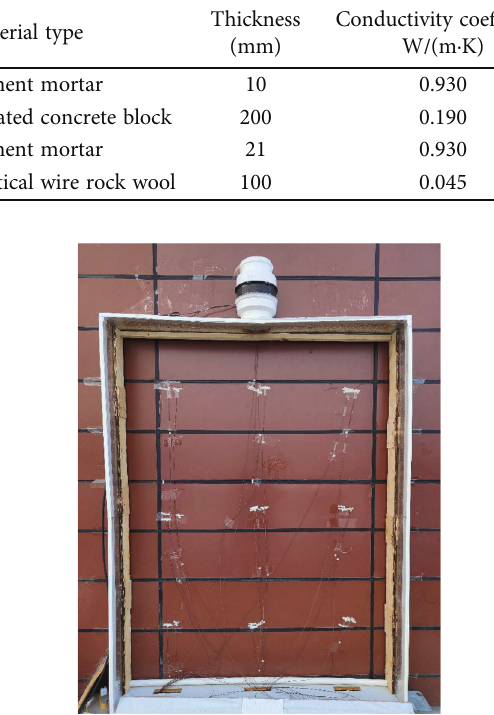
Figure 2: Physical diagram of heat recovery type of heat storage